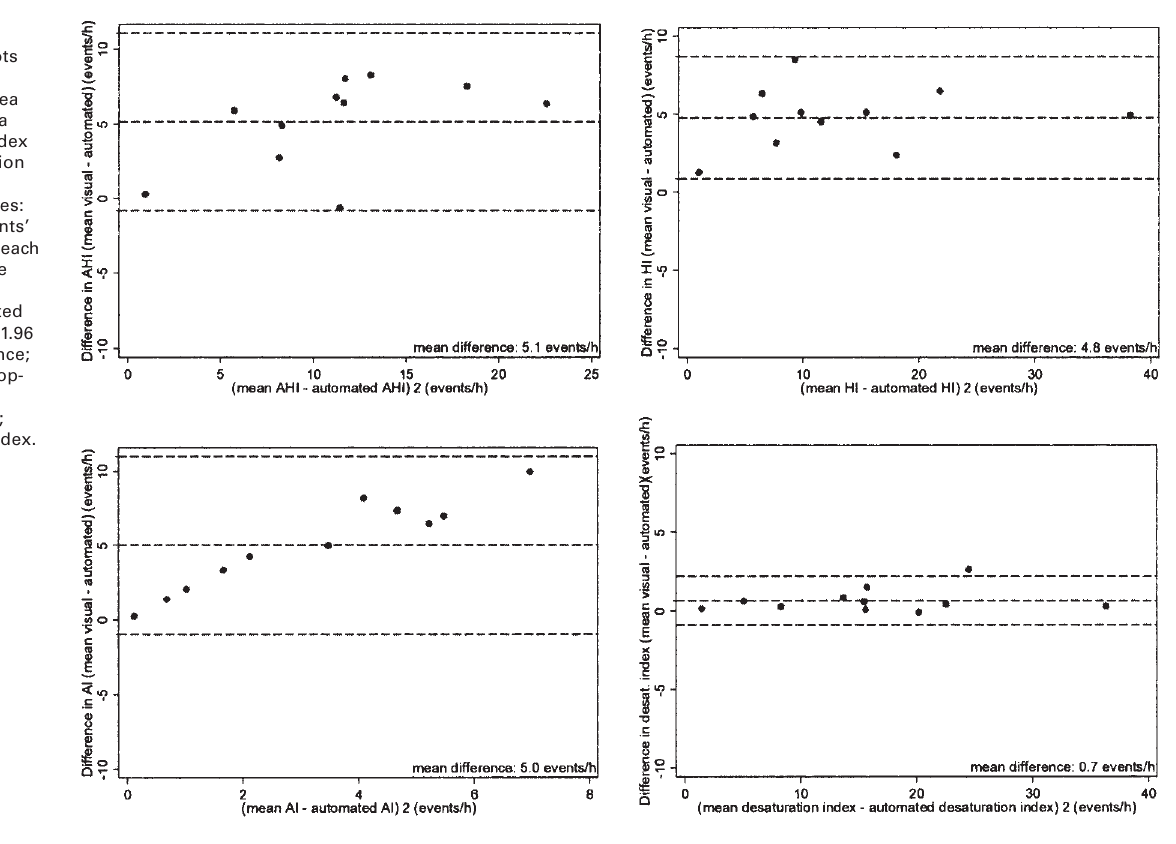
Figure 2 Bland Altman plots of differences in apnoea hypopnoea index, hypopnoea index, apnoea index and O 2